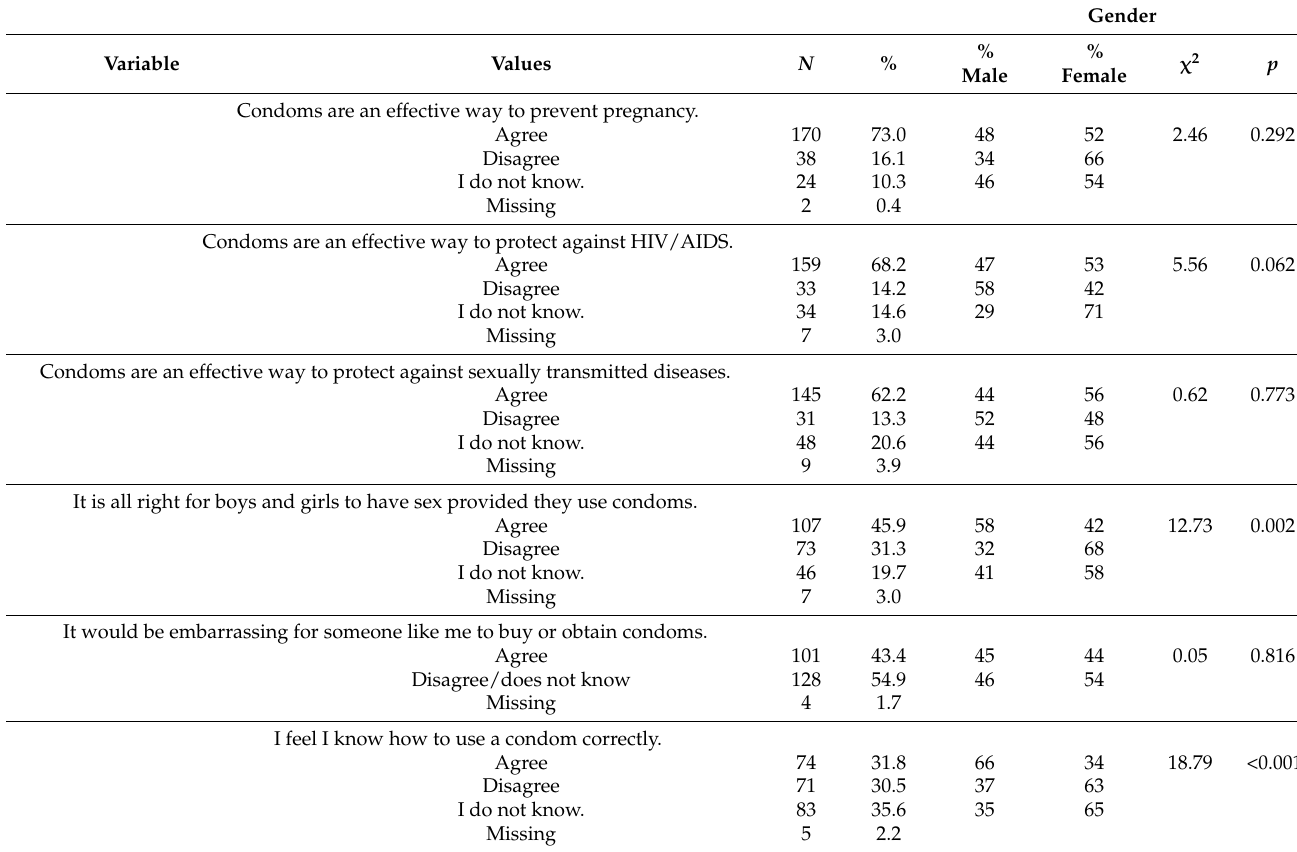
Table 4. Knowledge and attitudes toward condom use and relationship norms according to gender of respondent (N = 233).